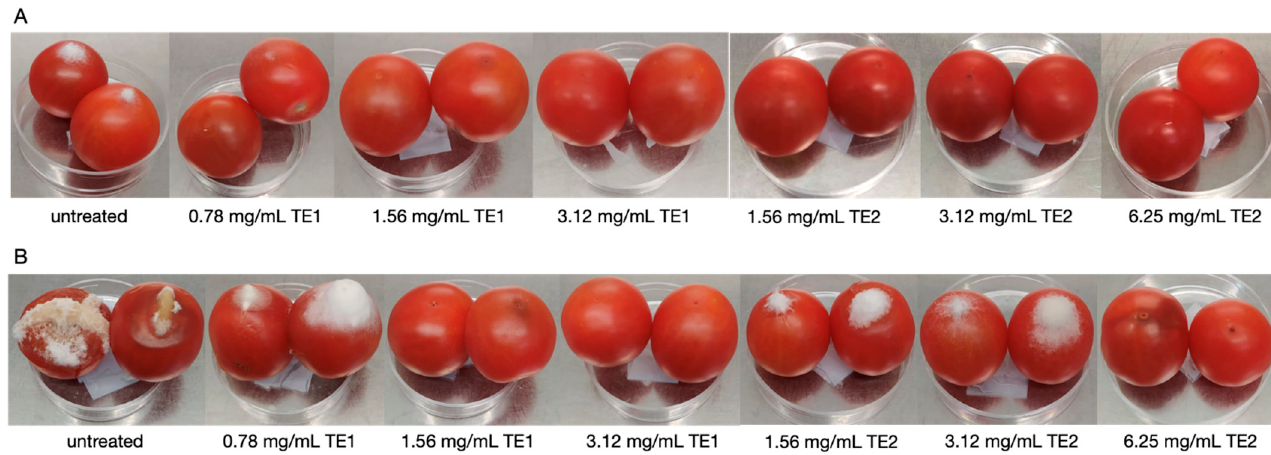
Figure 4. Mycelium growth of Fusarium graminearum on tomatoes treated with TE1, TE2 and untreated at ( A ) 4 and ( B ) 11 days incubation.